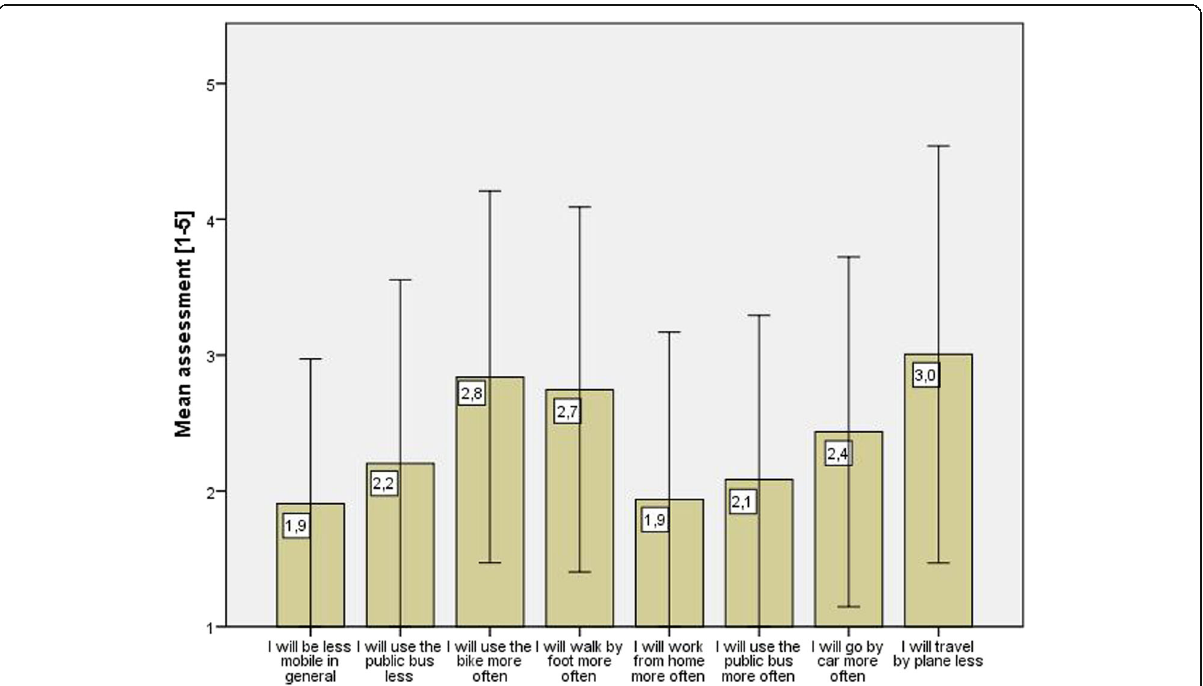
Fig. 3 Mean assessment of long-term changes in mode choice. Note . Whiskers represent 1 standard deviation. 1 = fully disagree, 5 = fully